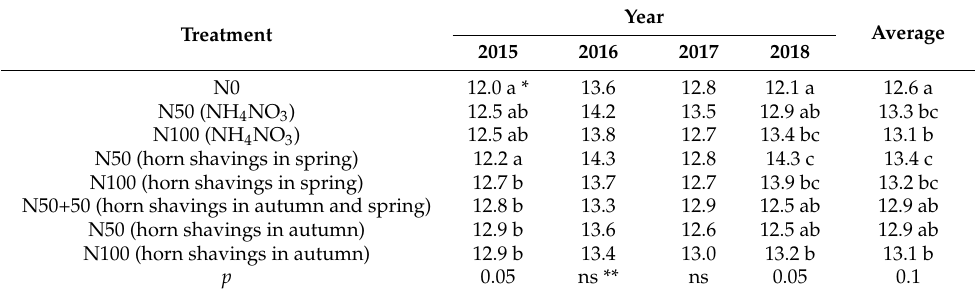
Table 8. Fertiliser effect on Ligol apple soluble solids content (SSC,